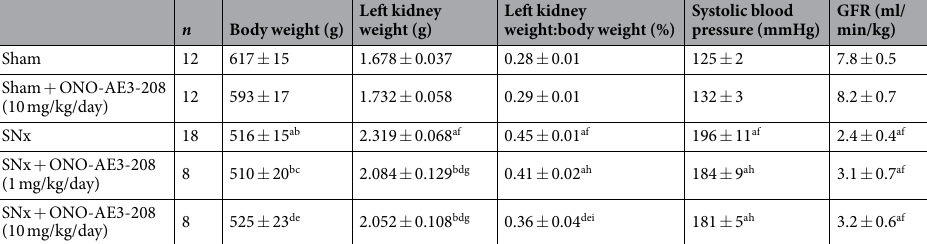
Table 3. Metabolic characteristics of sham-operated and subtotally nephrectomized (SNx) rats treated with vehicle (drinking water) or ONO-AE3-208 for seven weeks. a p < 0.0001 vs. sham, b p < 0.01 vs. sham + ONO-AE3-208, c p < 0.001 vs. sham, d p < 0.01 vs. sham, e p < 0.05 vs. sham + ONO-AE3-208, f p < 0.0001 vs. sham + ONO-AE3-208, g p < 0.05 vs. SNx, h p < 0.001 vs. sham + ONO-AE3-208, i p < 0.001 vs.